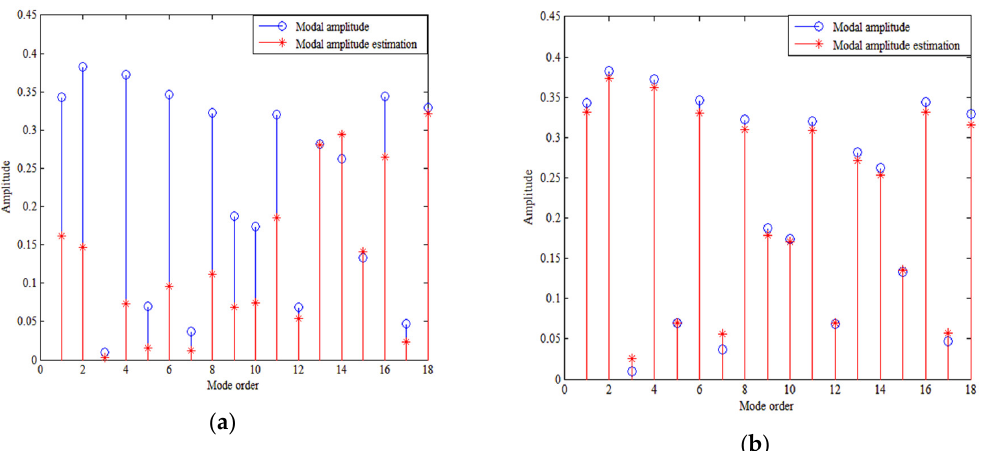
Figure 7. Modal amplitudes estimated by TLS algorithm with ( a ) 50 sensors and ( b ) 150 sensors. Depth of source and HLA are 50 m. SNR is 20 dB.